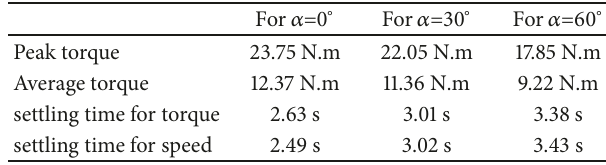
Table 2: relative torque ripple rate as function different shifts. Table 3: Effect of an angular offset on the operating characteristics of the